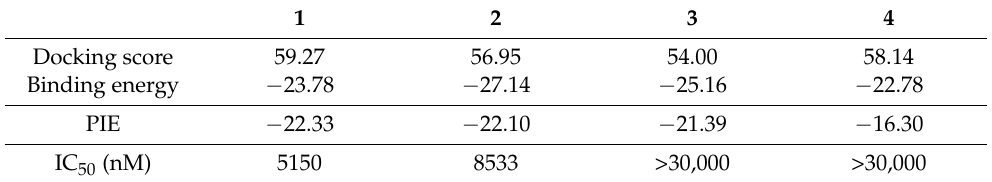
Table 1. Docking score, binding energy, PIE, and in vitro assay results for compounds 1-4 against PAK4.